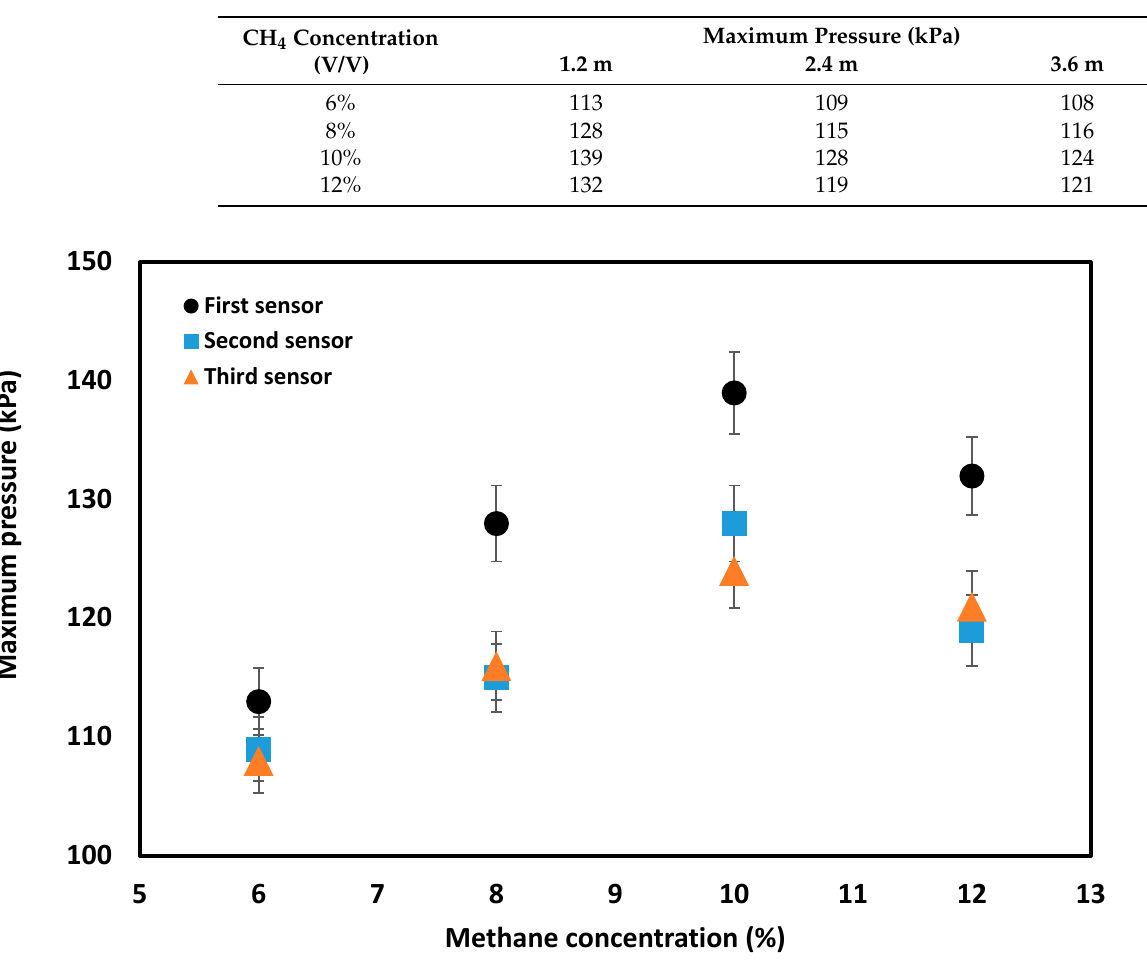
Figure 4. Pressure verses methane concentration readings recorded by three pressure sensors at placed 1.2, 2.4 and 3.6 m from the ignition source, assuming 2.5% systematic and random errors.